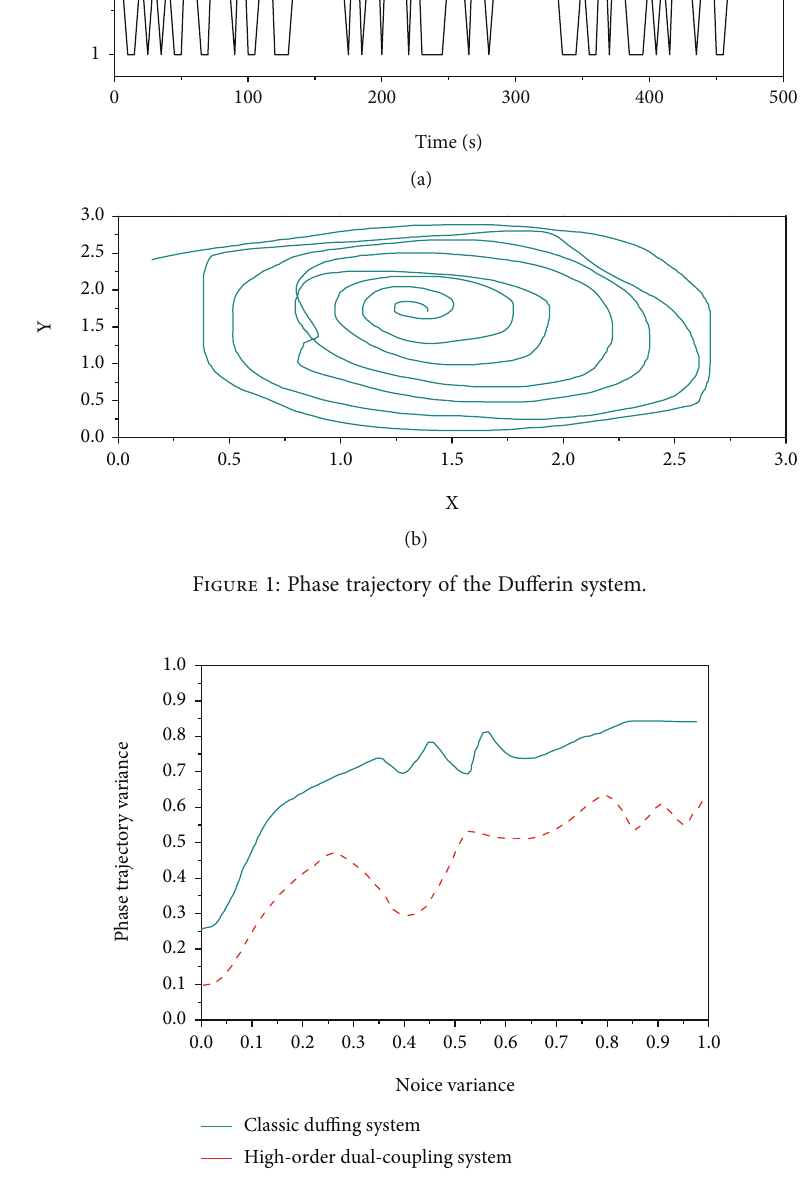
Figure 2: Comparison of noise immunity of double-coupled system and classical system.